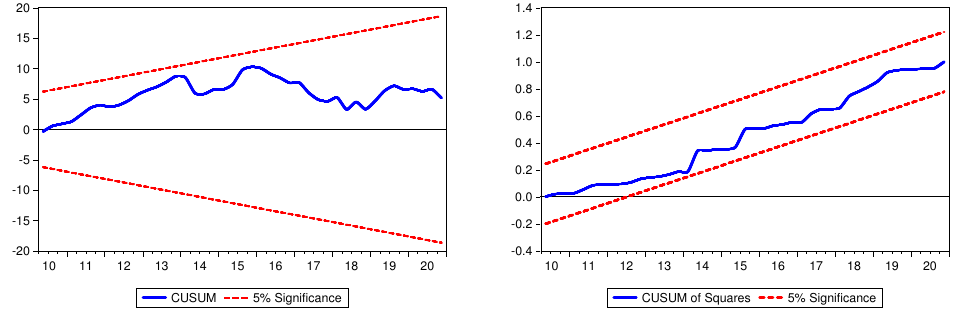
Figure 2. Stability test. CUSUM plot on left-side; Squares CUSUM plot on the right-side. The red dot-lines represent critical bounds at the 5% significance